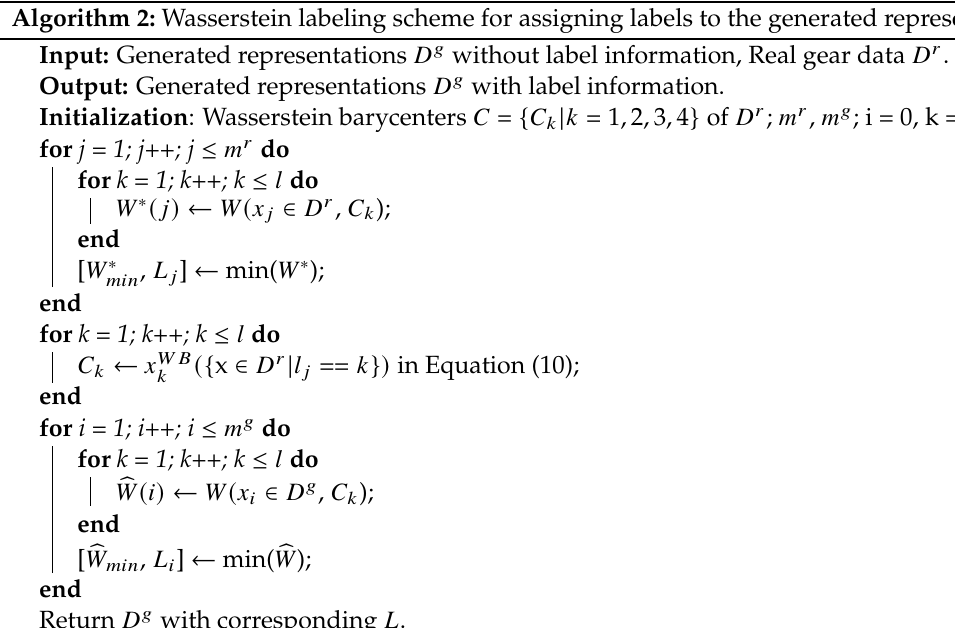
Algorithm 2: Wasserstein labeling scheme for assigning labels to the generated representations Input: Generated representations 𝐷 𝑔 without label information, Real gear data 𝐷 𝑟